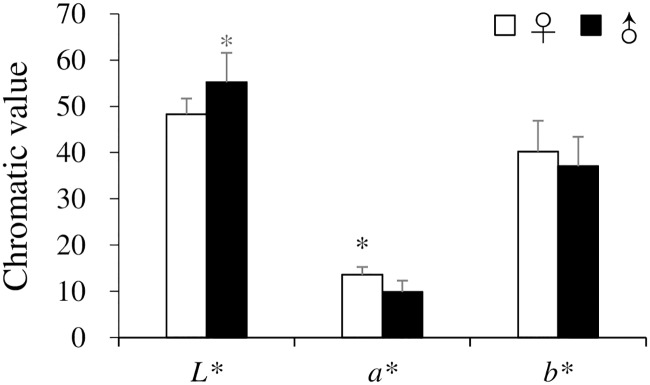
Gonad color (L*, a*, b*) (mean ± SD) of female and male Heliocidaris crassispina collected in August 2014.Asterisks indicate significant sexual difference (p < 0.05).